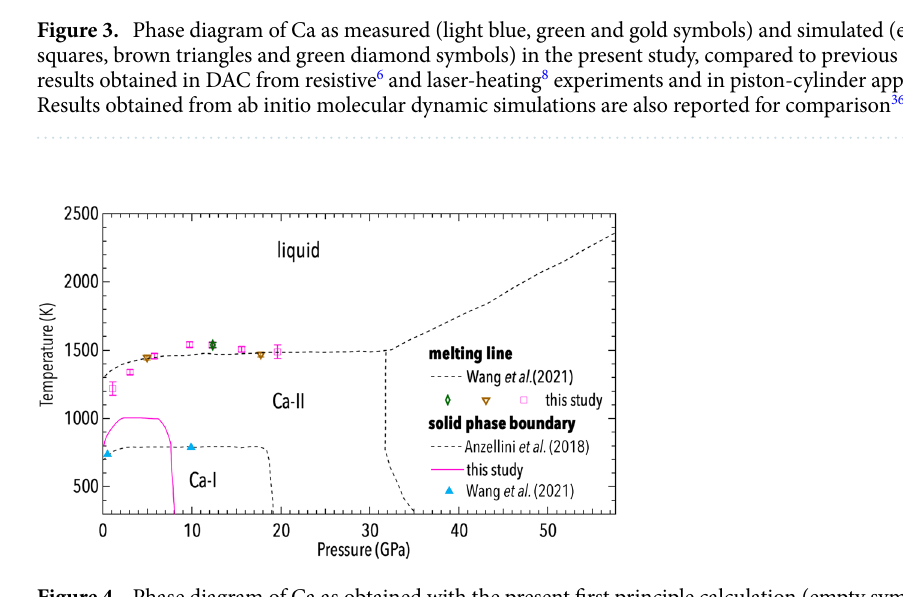
Figure 4. Phase diagram of Ca as obtained with the present first principle calculation (empty symbols and pink continuous line) and a previous study based on ab initio molecular dynamics simulation 36 (dashed black line and light blue triangle) and a high P - T experiment (dashed black lines) 6 . The different symbols used in the graph represent the three different approaches used for the simulations. In particular: the pink squares represent the simulation obtained with 2 valence electrons and 1000 atoms; the brown triangles are obtained using 10 valence electrons and 1000 atoms; the green diamond are obtained using 2 valence electrons and 1960